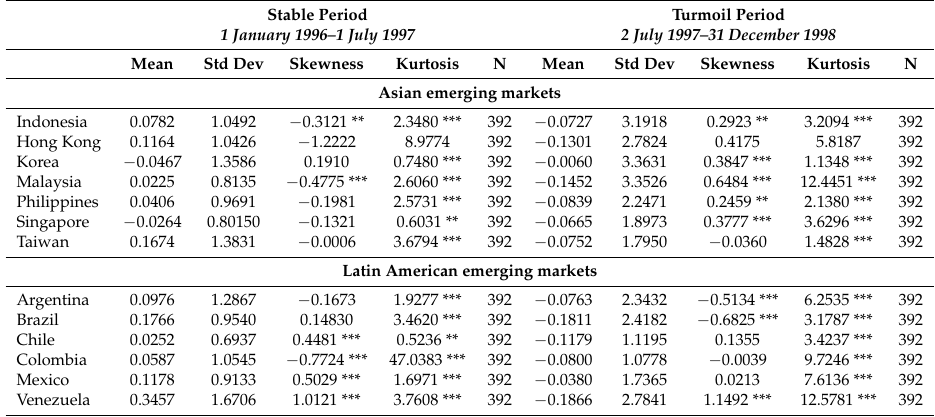
Table 2. Descriptive statistics on stock returns: The Asian crisis (Source of contagion: Thailand).